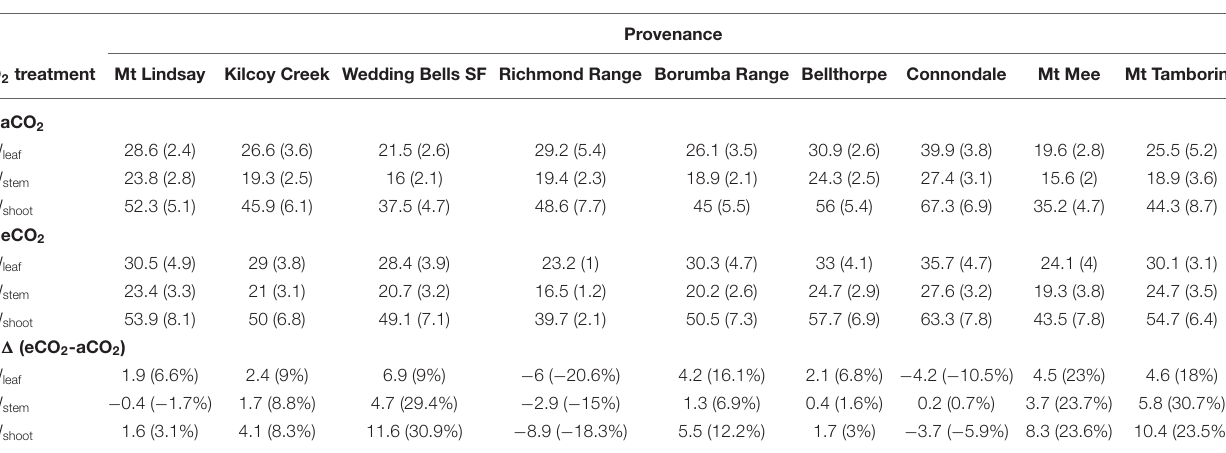
TABLE 5 | Dry mass (g) of E. grandis at the end of Experiment 2.